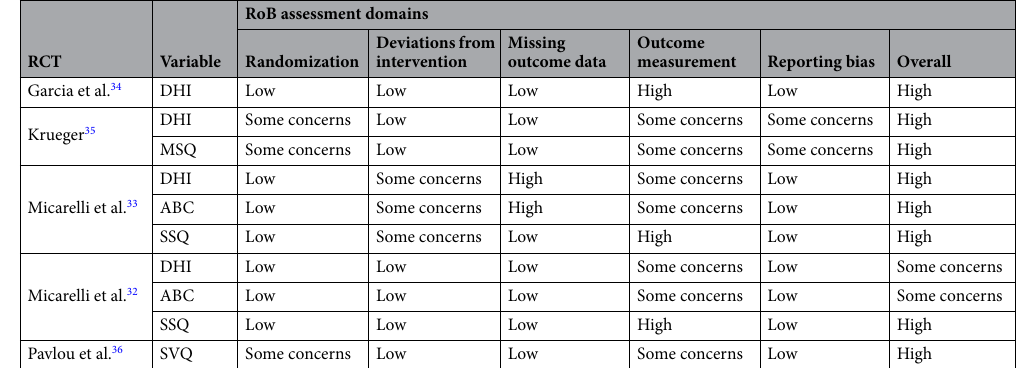
Table 2. Risk of bias assessment results for all included randomized controlled trials. ABC activities- specific balance confidence scale, DHI dizziness handicap index, MSQ motion sickness questionnaire, RCT